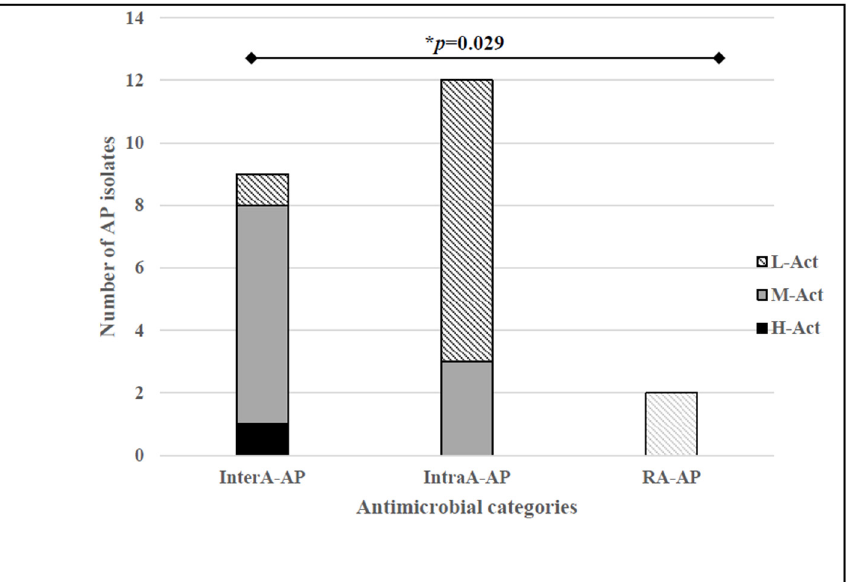
Figure 1. Number of antimicrobial producer (AP) isolates of each established antimicrobial categories (InterA-AP, IntraA-AP and RA-AP) that present high, medium and low antimicrobial activity (H-Act, M-Act and L-Act, respectively). * Statistically significant differences were observed ( p ≤ 0.05).